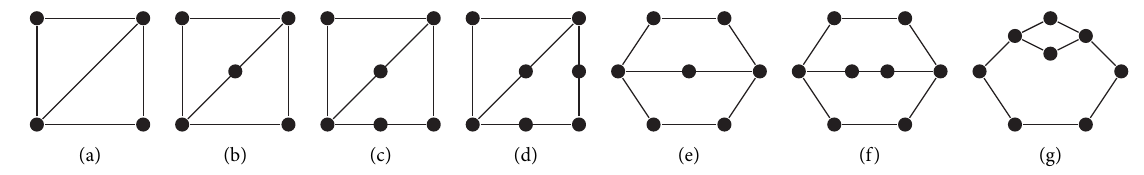
Figure 7: Bicyclic graphs with minimum edge Mostar index of order 4 ≤ n ≤ 8. (a) G